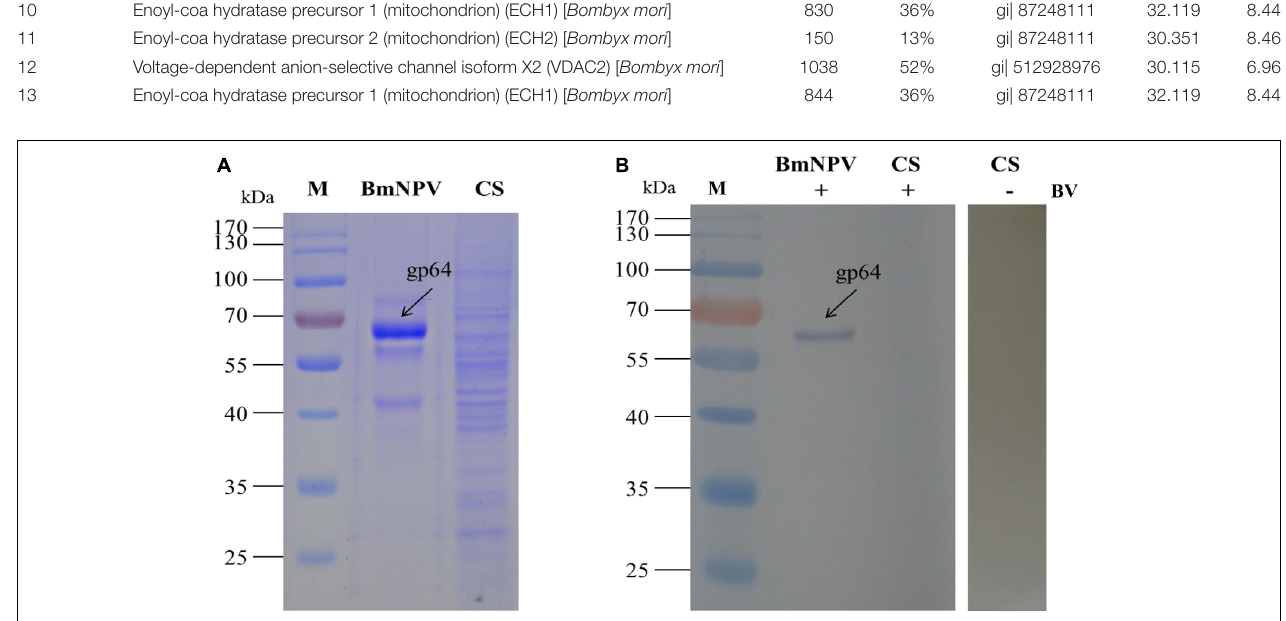
FIGURE 6 | Identification of virus-binding in the cytosol proteins fraction of the P50 midgut on SDS-PAGE. (A) Separation of cytosolic proteins of the BmNPV and Bombyx mori midgut samples by SDS-PAGE. (B) Virus overlay binding experiment. BmNPV and cytosolic protein samples blot were overlaid with BV (CS + BV), and a blot with CS without overlaid with BVs (CS-BV) are detected by antibodies against AcMNPV gp64 protein to detect the BVs. M, protein molecular weight